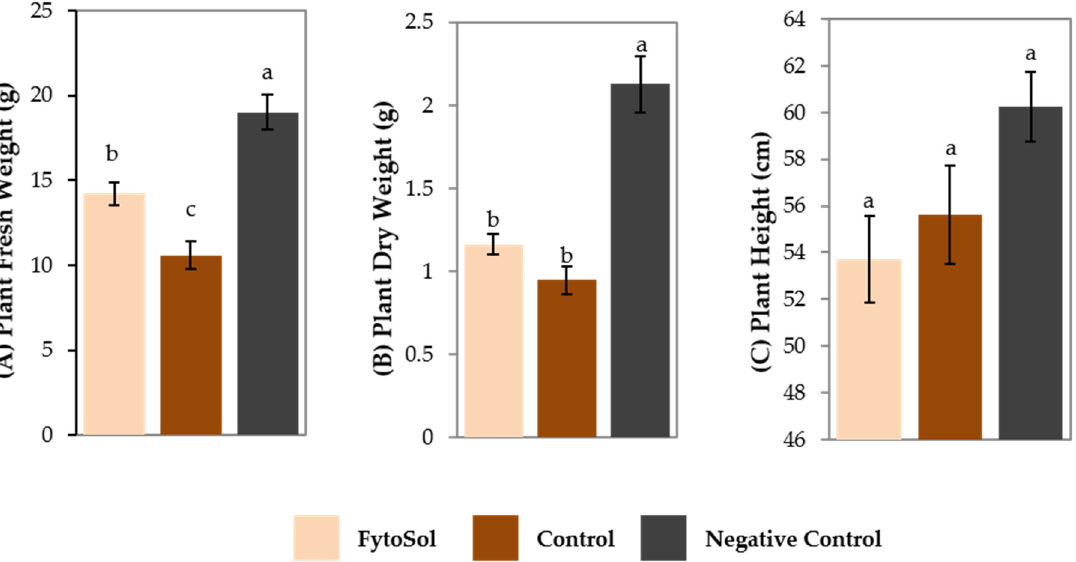
Figure 2. The effects of FytoSol on ( A ) plant fresh weight, ( B ) plant dry weight, and ( C ) plant height on Alternaria solani -infected or -uninfected (negative control) tomato plants. Columns with different letters are significantly different according to the LSD test ( p < 0.05).